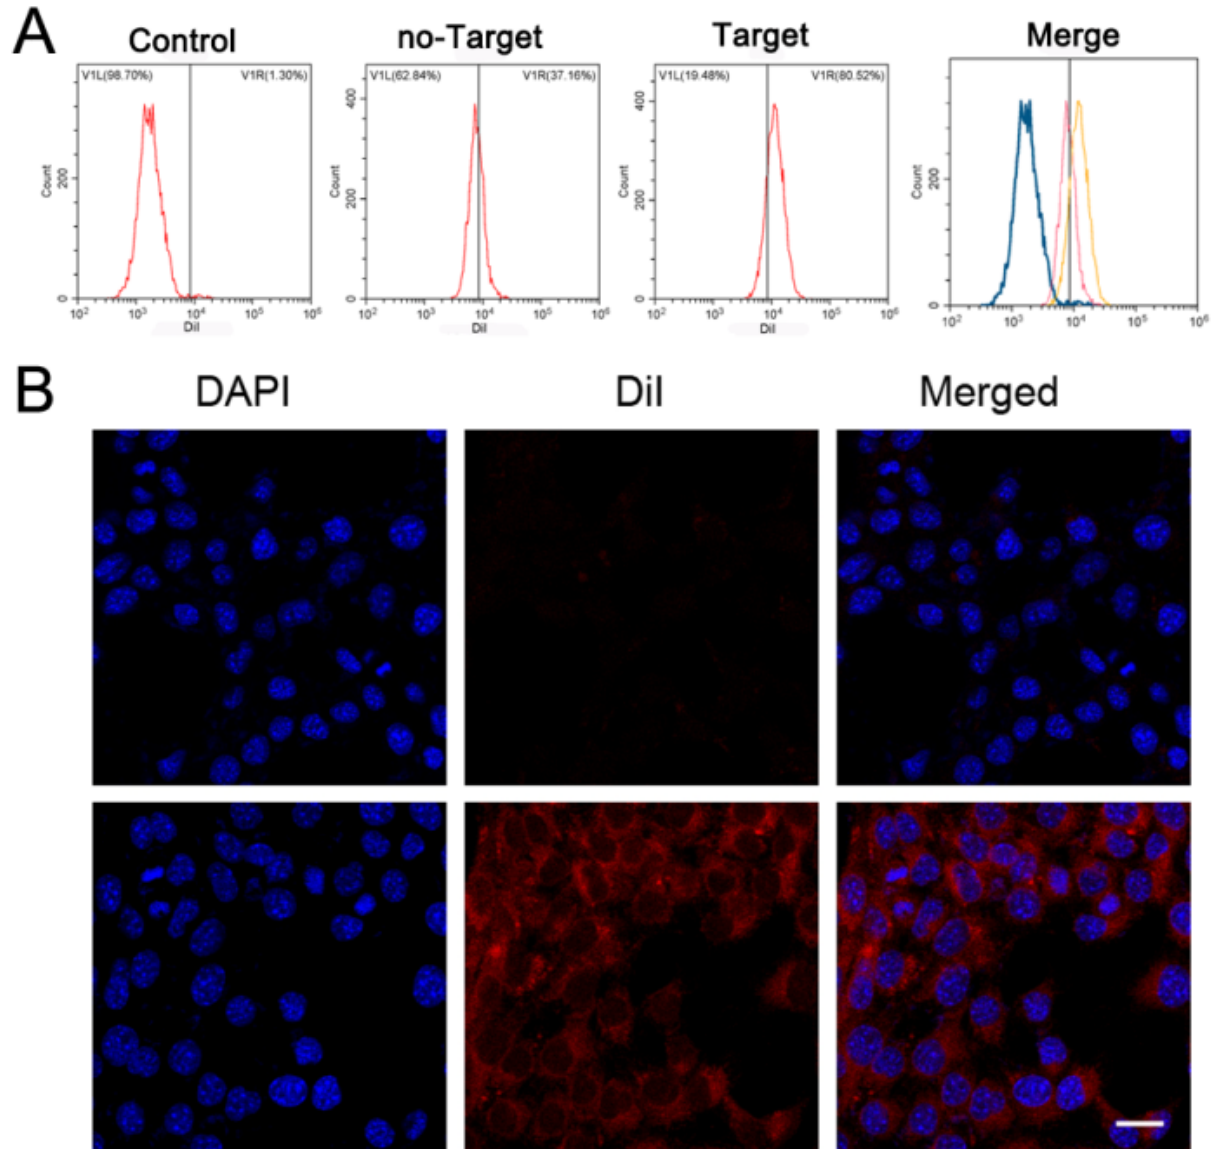
Figure 4. Cell-targeting experiments: ( A ) The connection between NPs and cells as detected by flow cytometry. ( B ) 2D images of the connection between NPs and cells observed by LSCM. Up: control; Down: PSMA-targeted nanoparticles. Scale bar: 20 μ m.